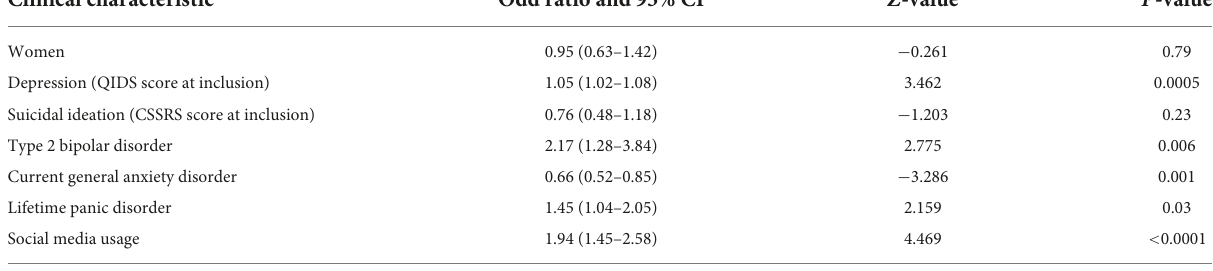
TABLE 4 Satisfaction scores from the MARS